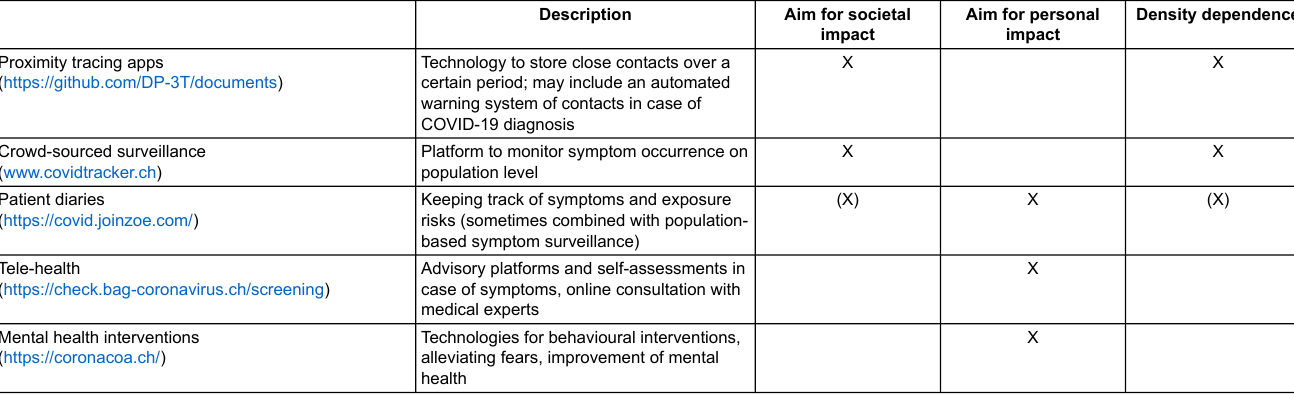
Table 1: Typology of different apps and technologies in the context of COVID-19 that are aimed at the broader public.